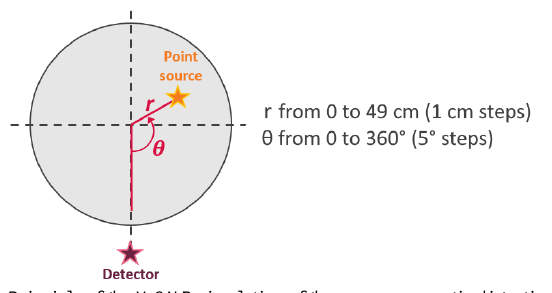
Fig. 4. Principle of the MCNP simulation of the gamma-ray ratio distortion